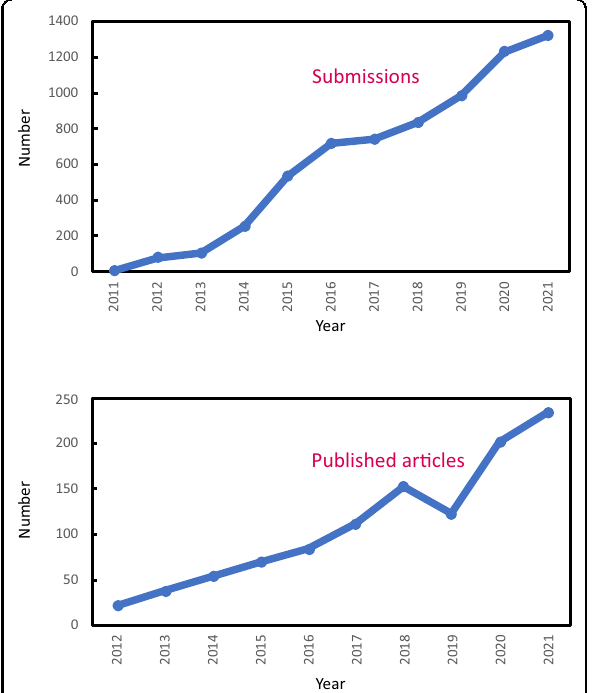
Fig. 3 LSA trends on contributions and publications.